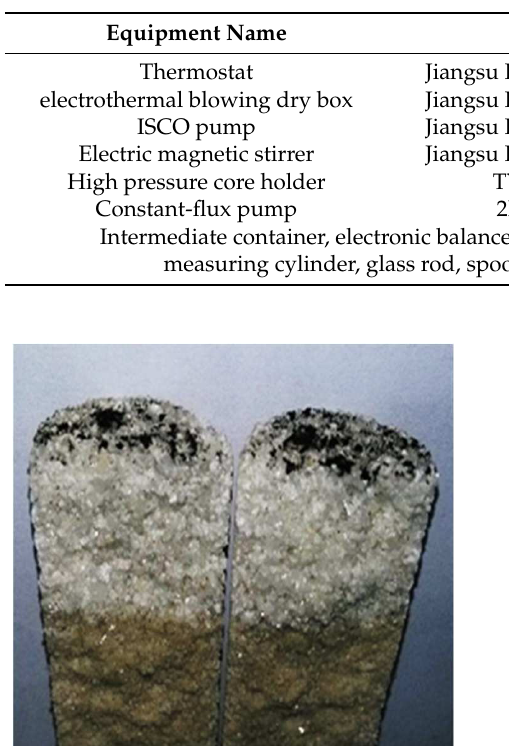
Table 19. Problems and solutions in the experiments.